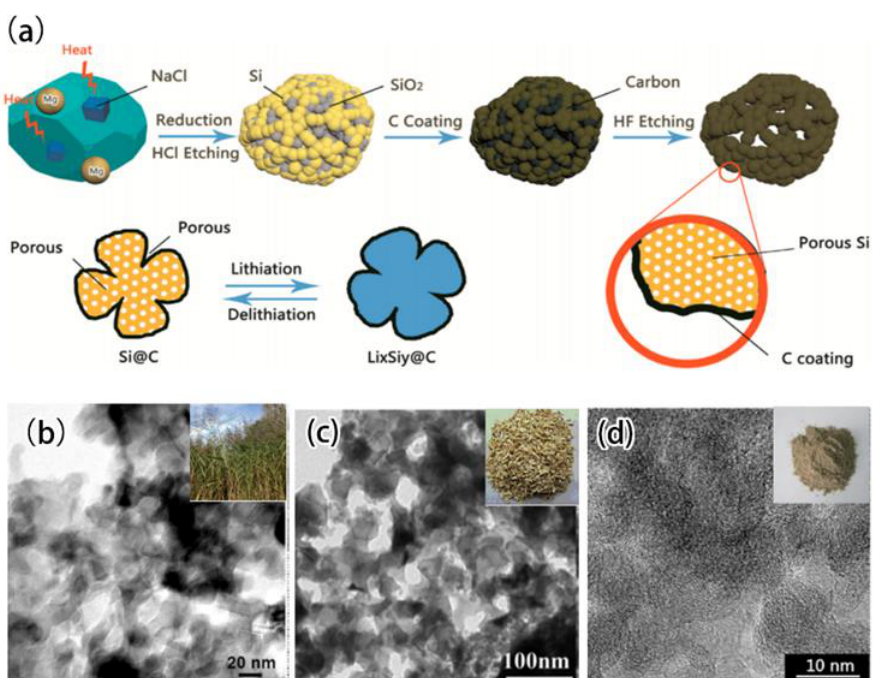
Figure 10. ( a ) Schematic illustration of the preparation process of porous silicon from diatomite. TEM images of porous silicon from ( b ) reed [77], ( c ) rice husk [79], ( d ) diatomite [82]. Reprinted with permission from [77]. Copyright 2015 John Wiley and Sons. Reprinted with permission from [79].